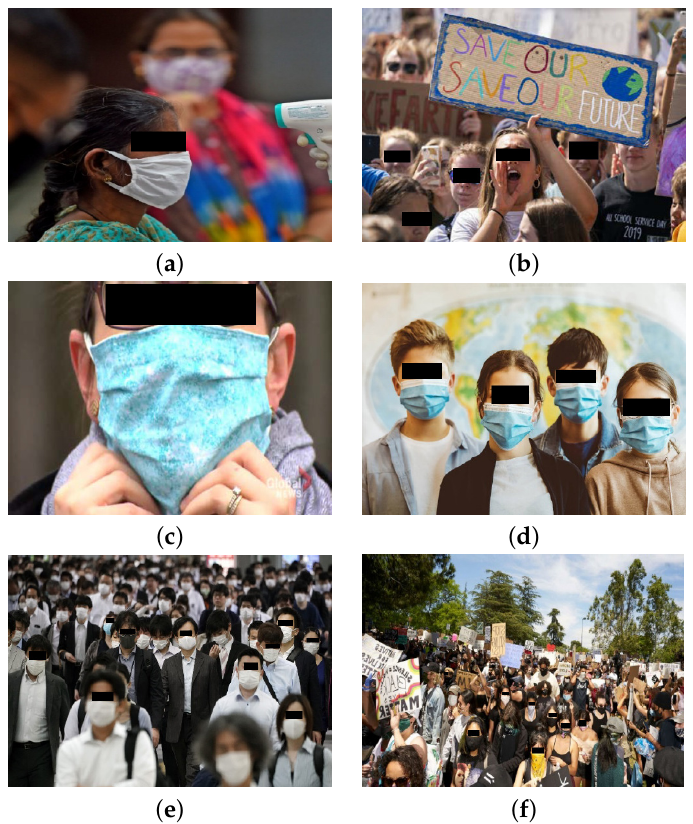
Figure 1. Indicative images of the FaceMask database. ( a ) Blurred faces, ( b ) obscured faces, ( c ) cropped faces, ( d ) individual faces, and ( e , f ) crowded images containing blurred, distant, and overlapped faces. Algorithm 1: Algorithm for downloading images and their URLs from the Web. procedure E XTRACTION OF THE URL S OF IMAGES